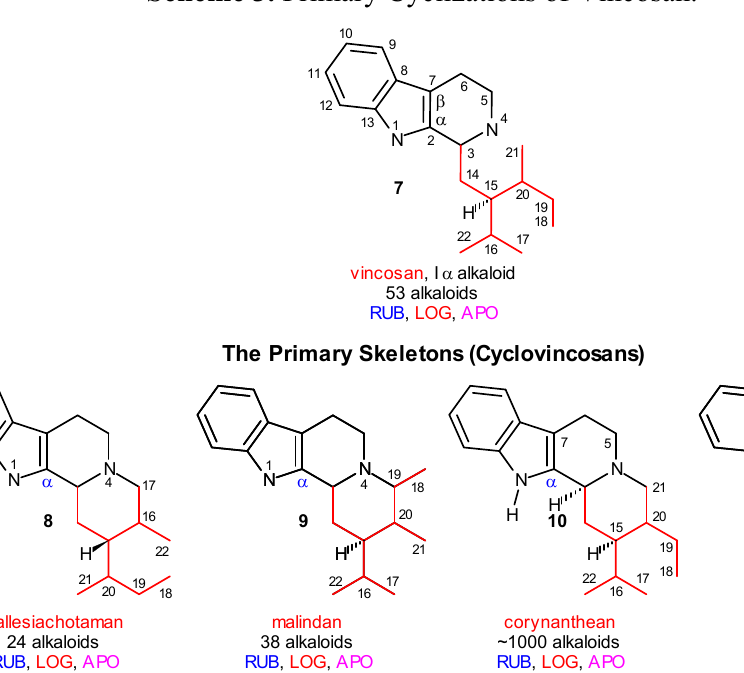
Scheme 3. Primary Cyclizations of